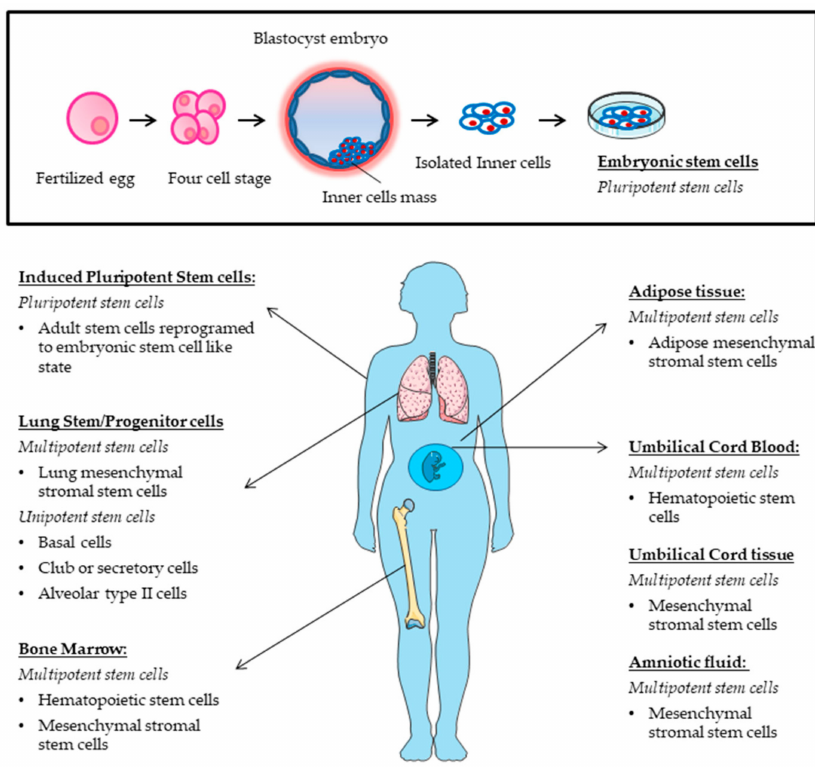
Figure 2. Schematic representation of the main sources for stem cells that have been used for the development of cellular therapies in pulmonary